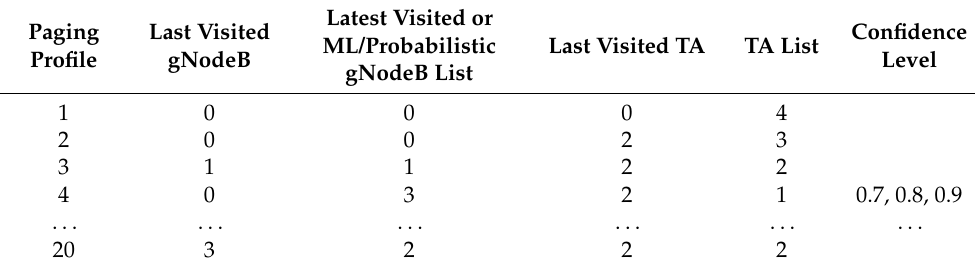
Table 4. Example of the proposed AMF paging profile configuration.